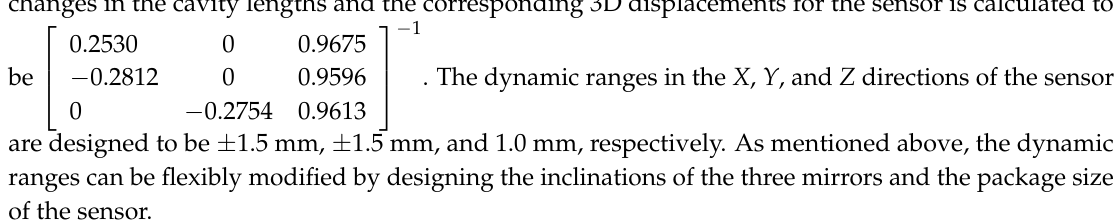
Figure 5. Measured cavity length change of EFPI 1 , EFPI 2 , and EFPI 3 with respect to temperature. 0